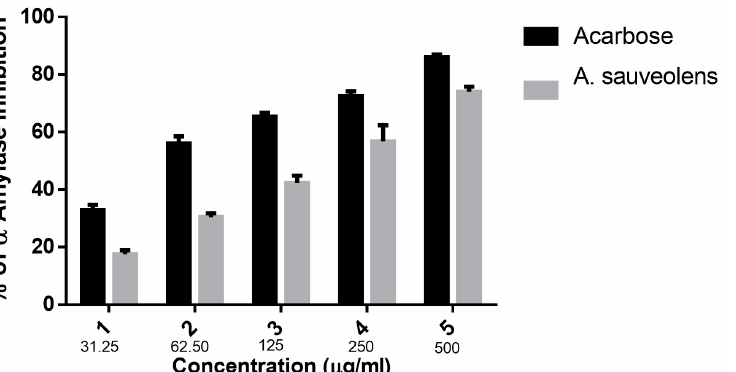
Fig. 2. Inhibition percentage of α-amylase against at different concentrations of Acarbose and A. suaveolens ; the IC50 value of the Acarbose and the extract were 49.19 ±8.1µg/mL and 282.32±8.7µg/mL, respectively. Values are presented as mean ± SD.